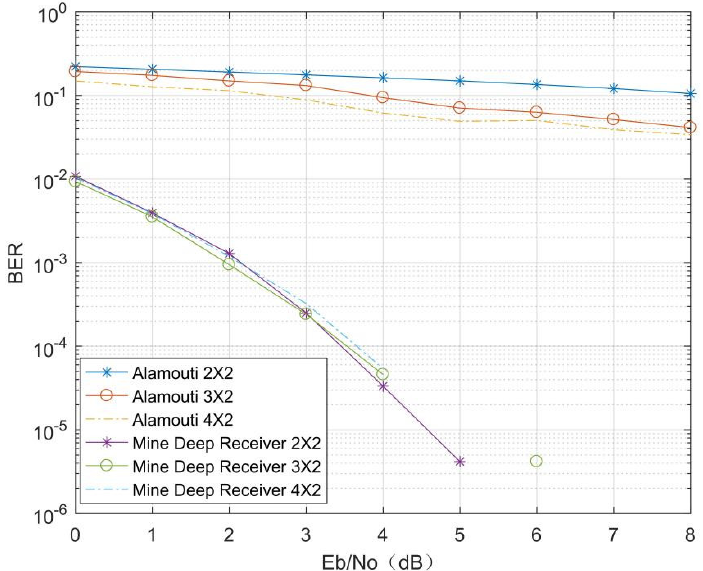
Figure 9. Comparison of different transmitting antennas.